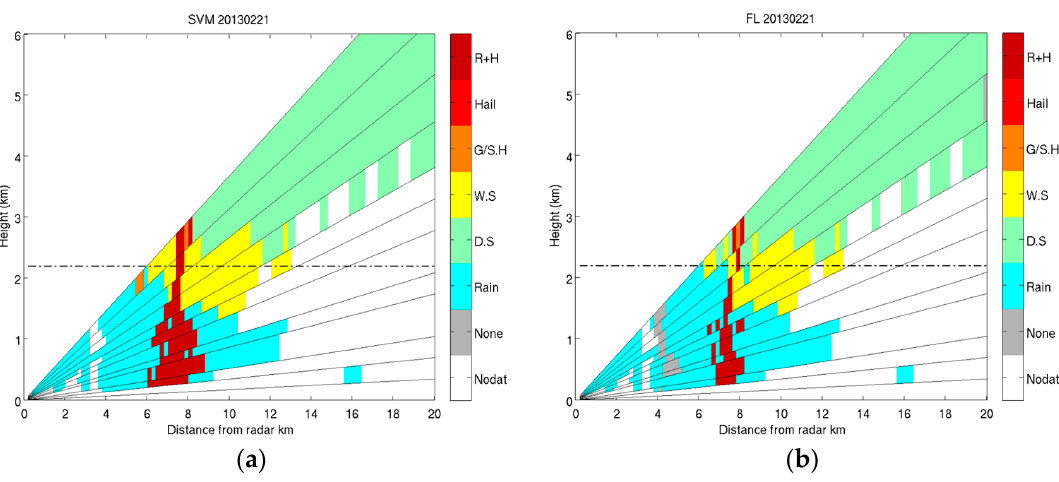
Figure 5. RHI sweep performed by Polar 55C on 15 October 2012 at 1738 UTC (293° azimuth) classified by SVM ( a ) and FL ( b ).